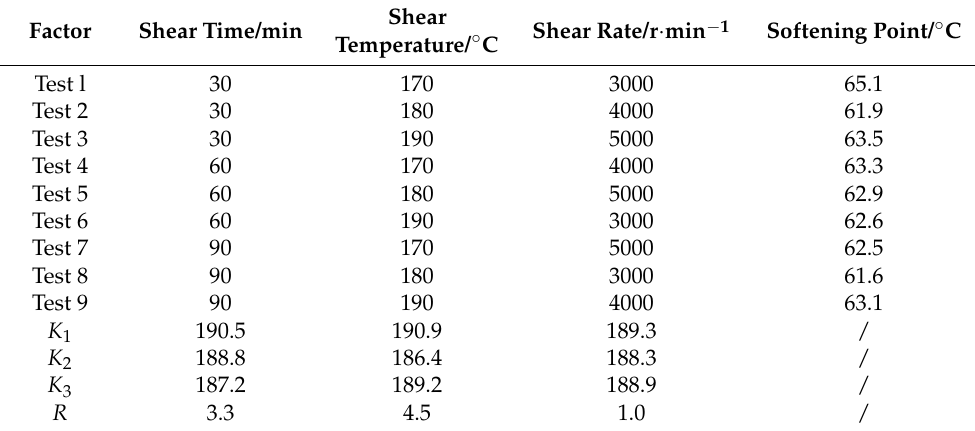
Table 6. PE Calculation results of softening point test R and K values of PE modified asphalt.